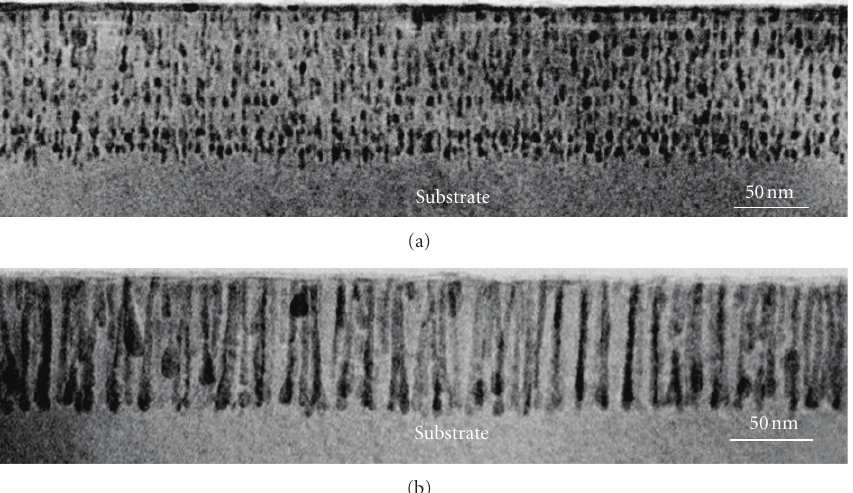
Figure 17: Typical TEM images of samples with di ff erent spacer thickness, (a) Ge layer = 11 nm, GeMn layer = 1.2 nm, (b) Ge layer = 4.6 nm, GeMn layer = 3 nm. Reproduced from [20]. Copyright ©2011 Wang et al.; licensee